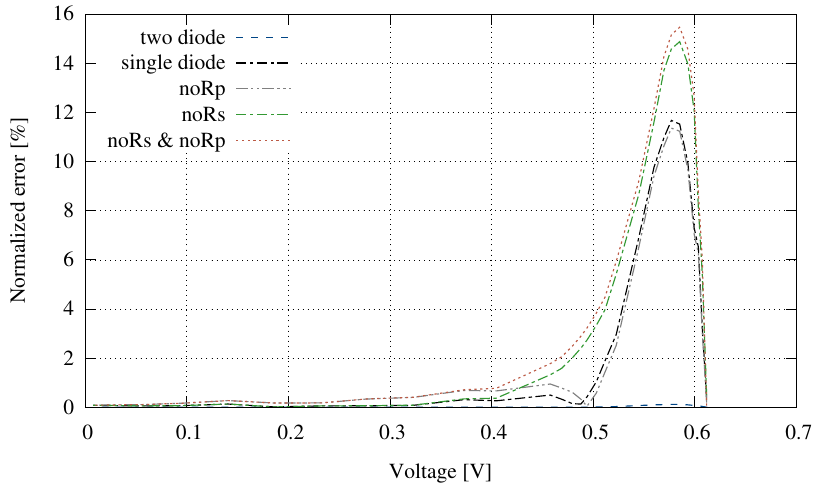
Figure 8. Normalized error obtained while reconstructing the Several I – V curve for Q.CELLS Q6ML-1600 PV module with different model